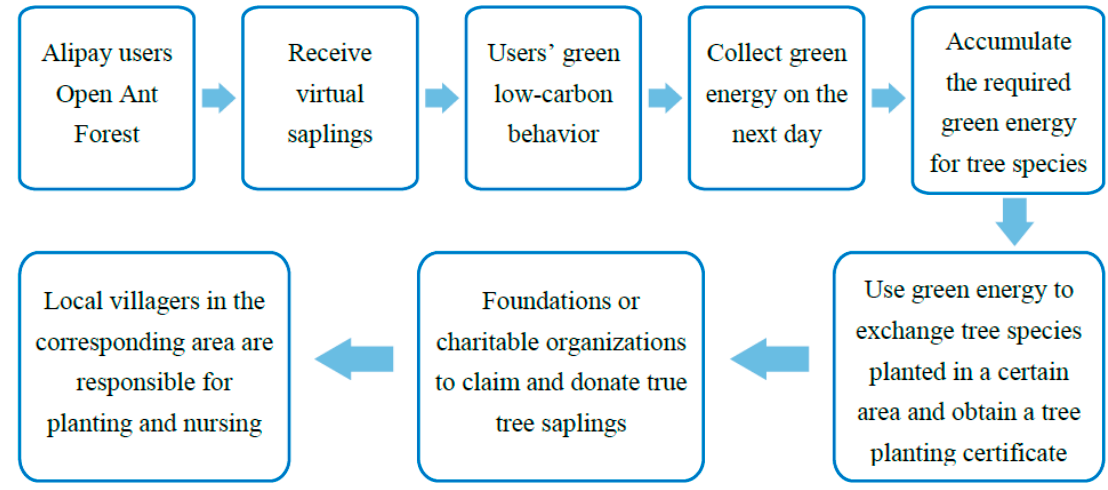
Figure 2. Ant Forest use process.